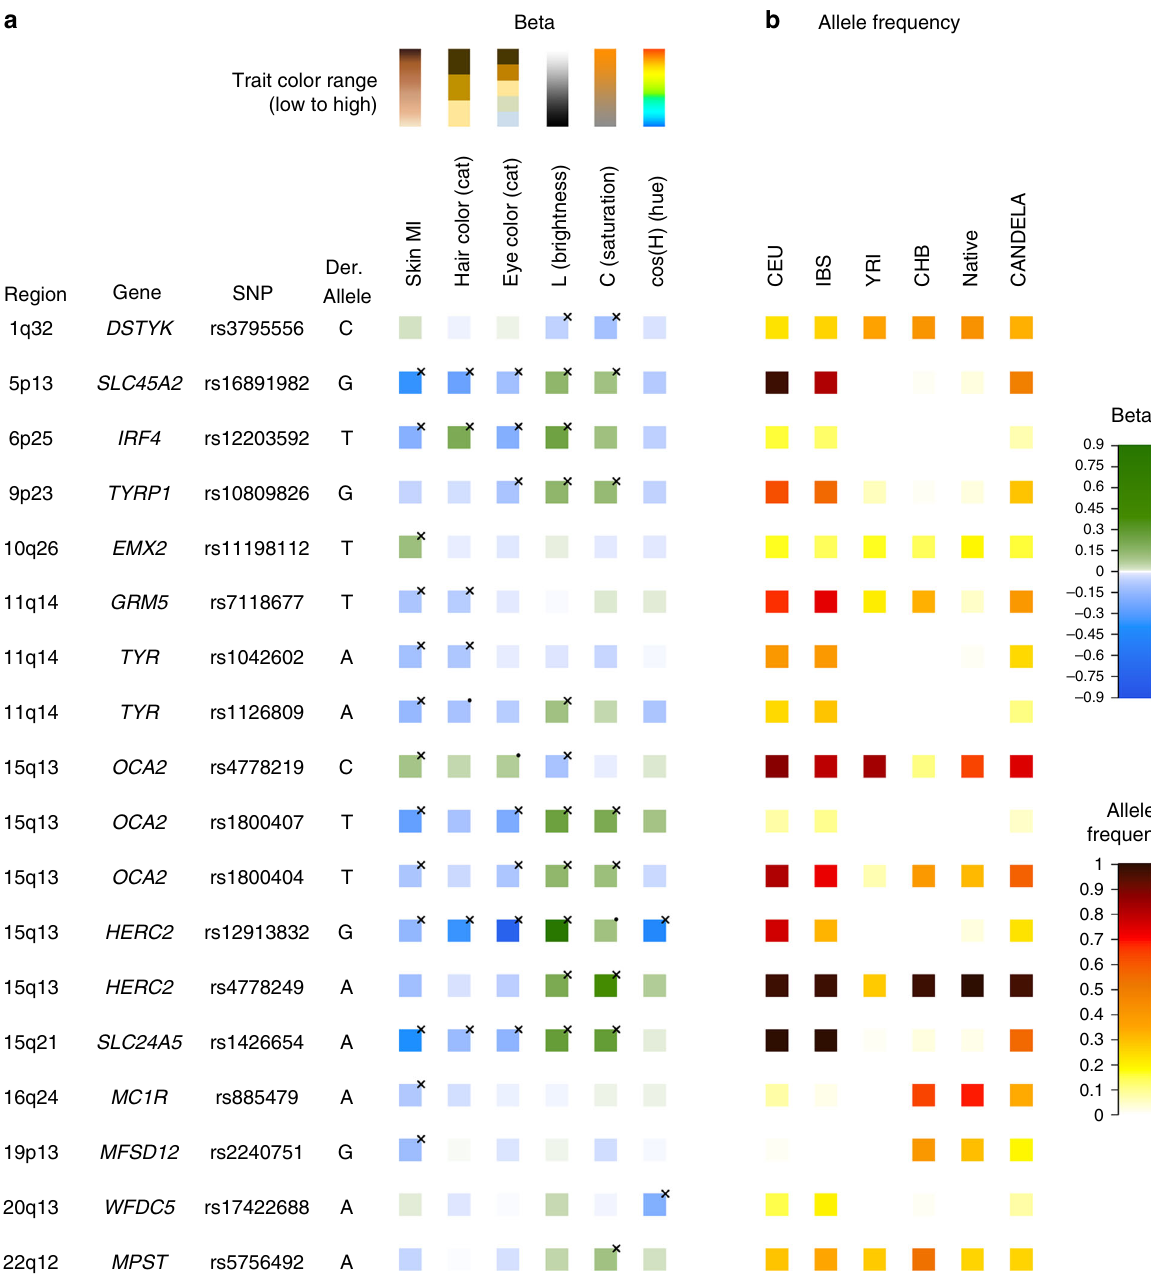
Fig. 4 Phenotypic effects (regression beta-coef fi cients) and derived allele frequencies for the 18 index SNPs showing independent association in the CANDELA sample (Table 1). In a traits are shown at the top, with illustrative color ranges. Beta-coef fi cients have been standardized to facilitate comparison across traits. Positive betas are shown in green and negative betas in blue (with color intensity re fl ecting beta values as indicated on the scale to the right). Signi fi cant betas are marked with a cross. In b allele frequencies are shown for the CEU, IBS, CHB and YRI samples from the 1000 Genomes Project Phase 3, the CANDELA sample and Native Americans (from Reich et al. 17 and Chacon-Duque et al. 79 ). On the right is shown the color scale used to represent allele frequencies (Supplementary Table